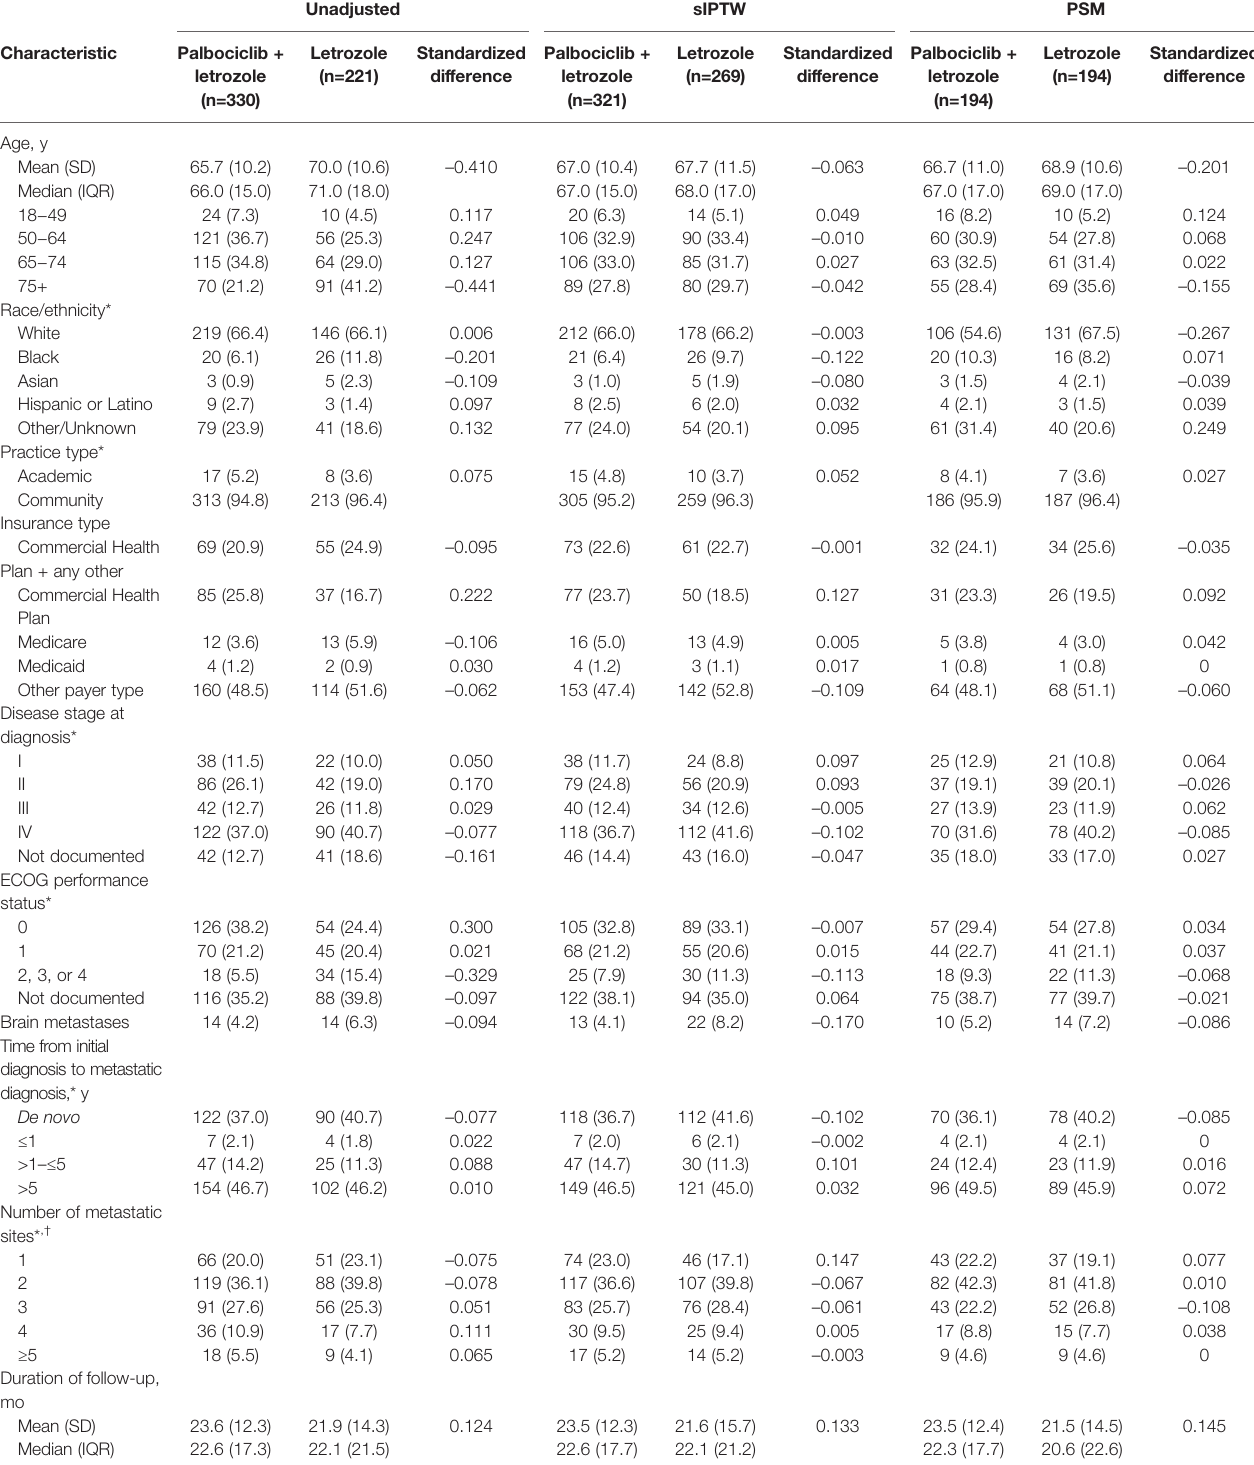
TABLE 1 | Patient demographic and clinical